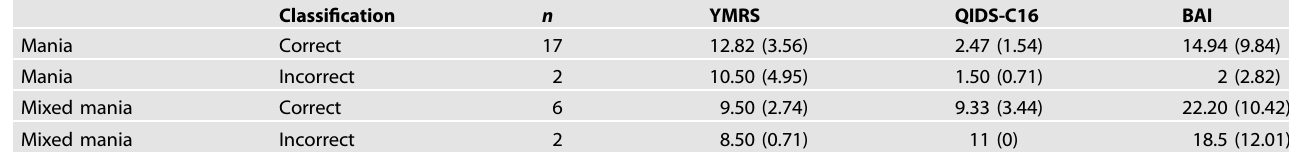
Table 5. Classi fi cation results in manic groups and descriptive clinical measures (mean and SD).